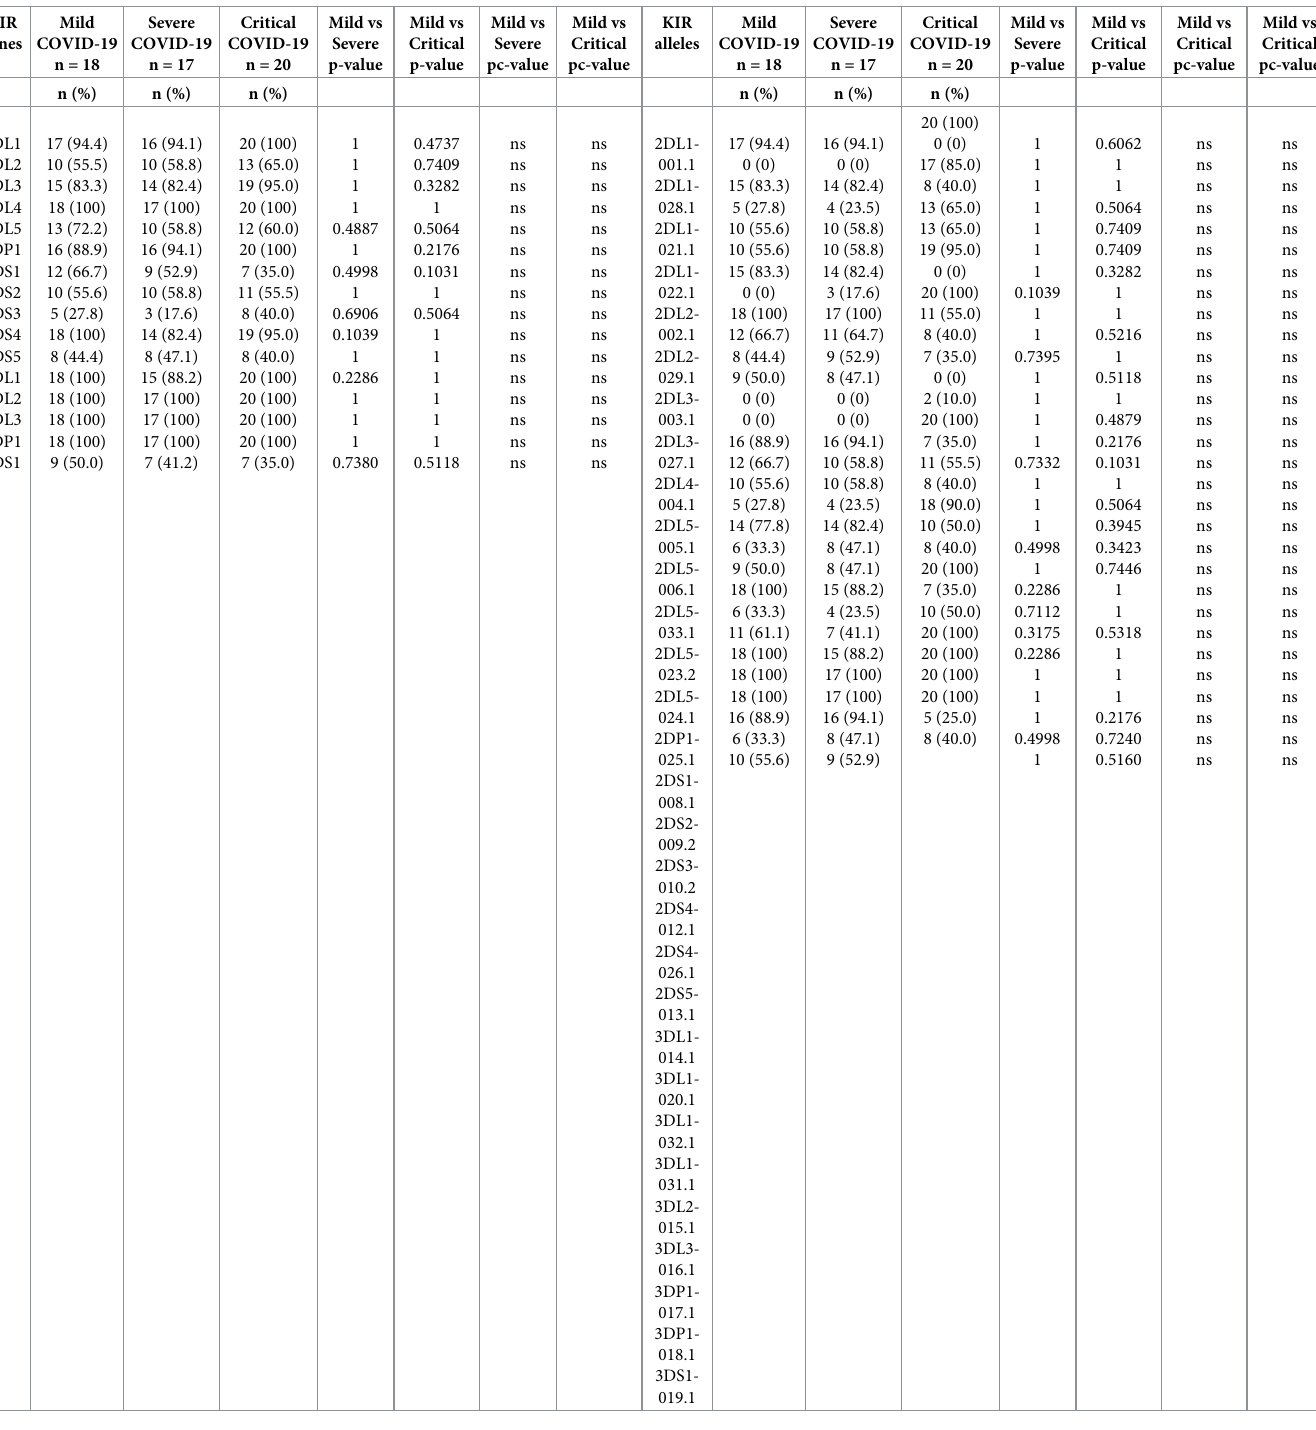
Table 5. KIR genes and alleles identified in individuals with mild, severe and critical COVID-19. The statistical significance of the comparisons between the frequen- cies of KIR genes and alleles in the groups of individuals with severe and critical COVID-19 and the group of individuals with mild COVID-19 was calculated using Fisher’s exact test 2x2. Significance levels were corrected by Bonferroni